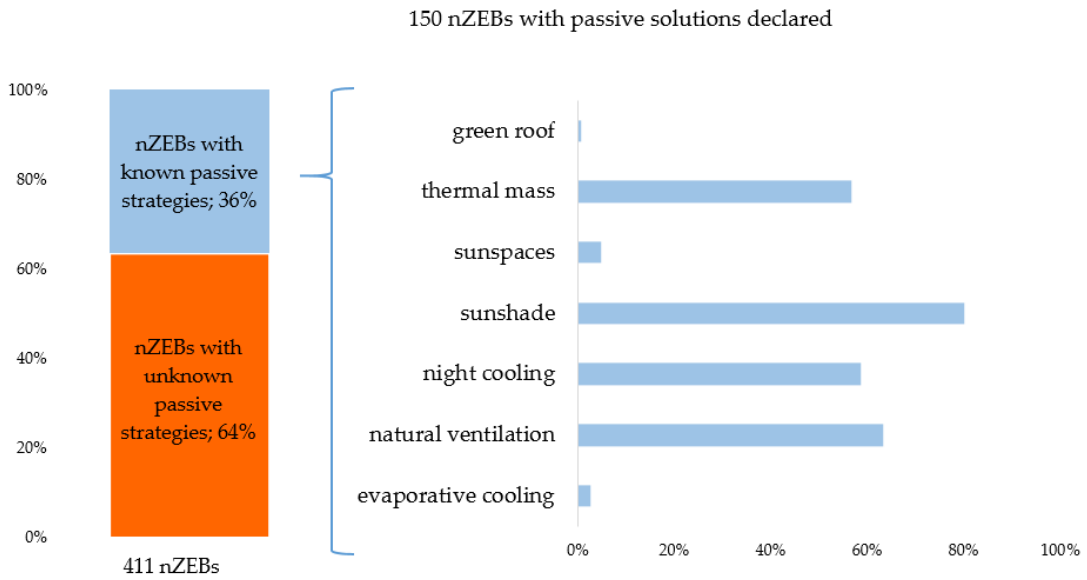
Figure 22. Share of known passive strategies used in nZEBs.